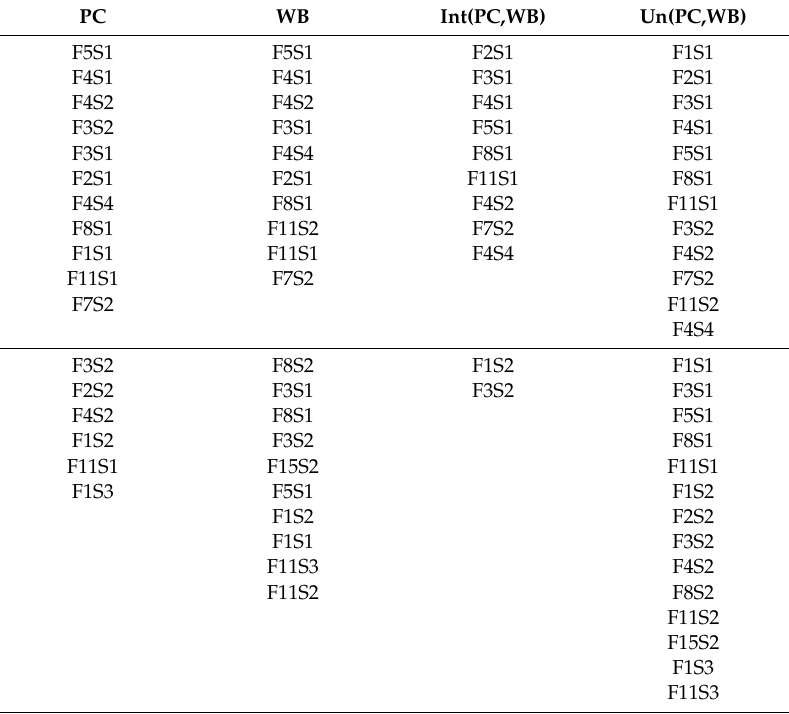
Table 6. Reduced feature sets for terrain ( a ) and slippage ( b )